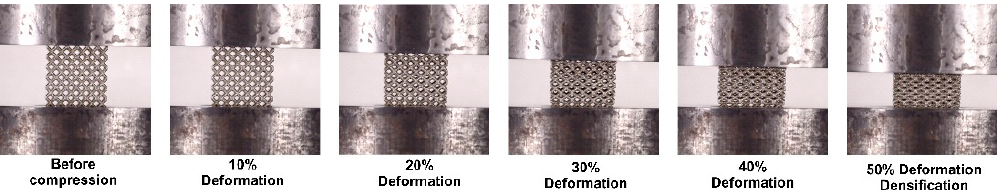
Figure 11. Deformation energy versus displacement history plots registered for various lattice structure specimens.